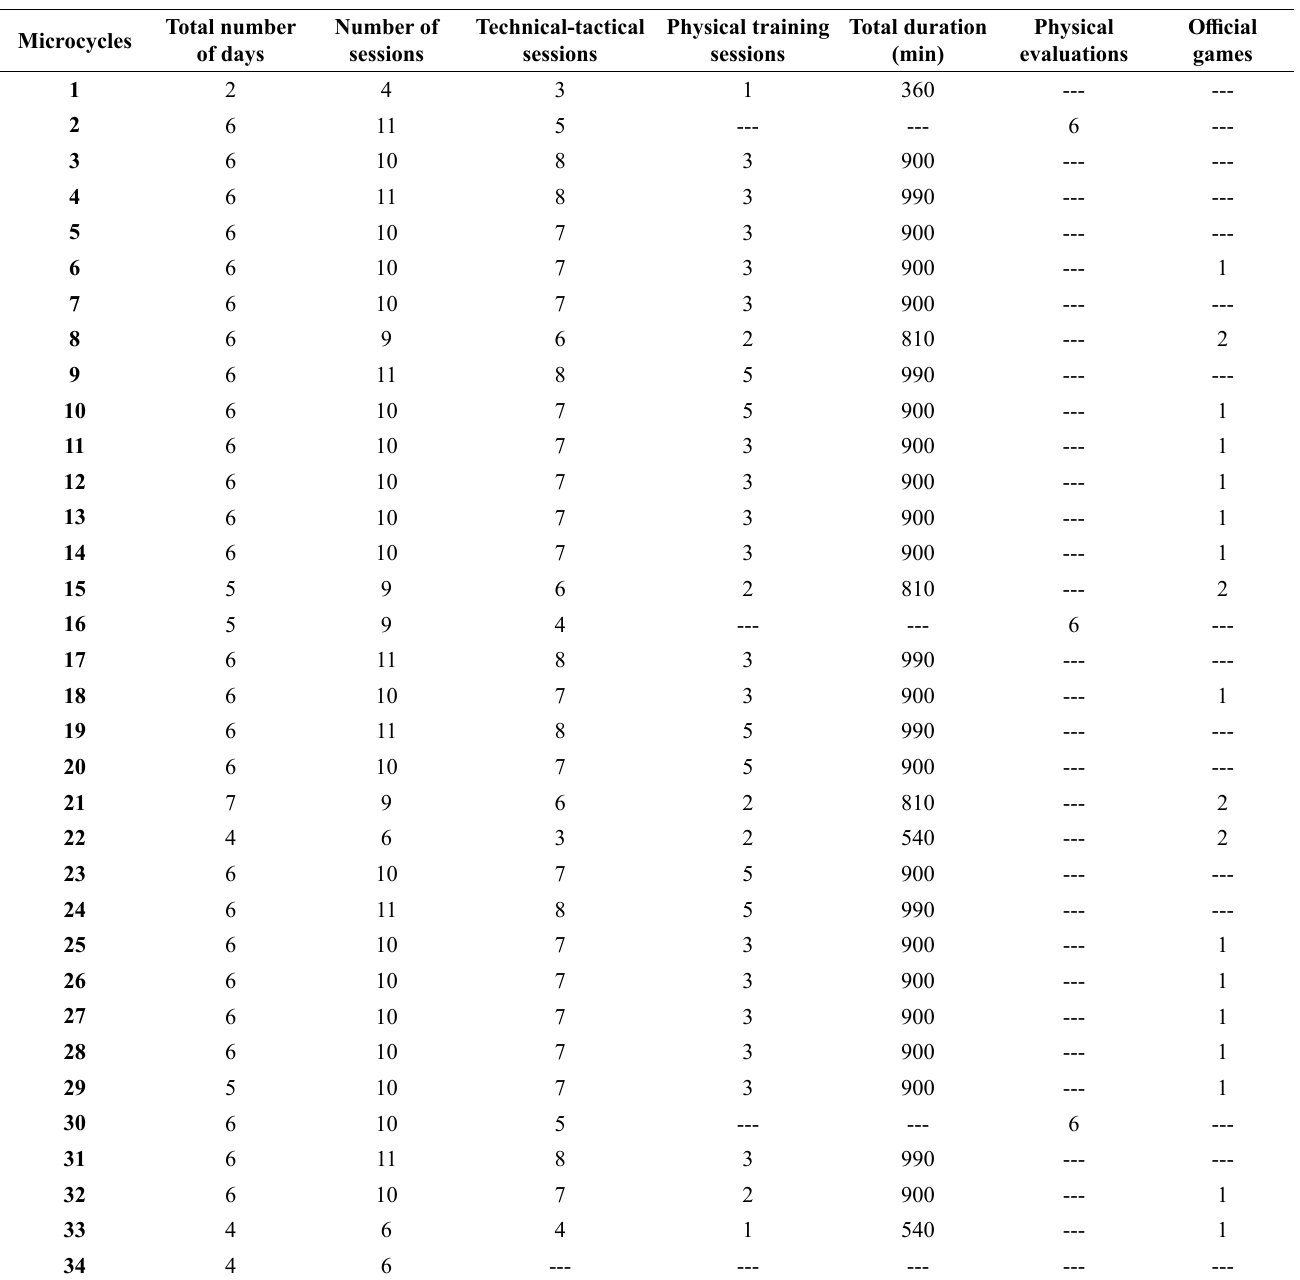
Table 1. Composition of training microcycles